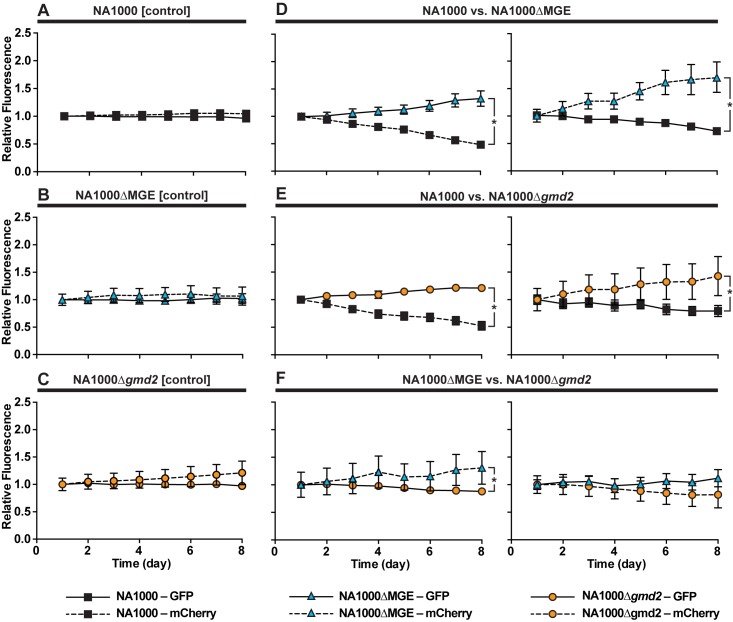
EPS production may be disadvantageous in phage-free environments.Strains labeled with two different fluorophores (GFP, mCherry) were mixed and relative fluorescence measured over the course of 8 days. (A–C) In control experiments where strains of the same genetic background expressing different fluorescent proteins were mixed, no significant change in the ratio of GFP:mCherry fluorescence was detected. Conversely, when strains of different genotypes were mixed, those producing more EPS appear to be at a competitive disadvantage (D) NA1000 and NA1000ΔMGE, (E) NA1000 and NA1000Δgmd2, or (F) NA1000ΔMGE and NA1000Δgmd2. The difference in fluorescence ratio between GFP and mCherry was assessed at the beginning (Day 1) and end (Day 8) of the experiment using an ANOVA with Bonferroni correction for multiple comparisons. Comparisons that resulted in significant differences are indicated with an asterisk (*) in the figure. (Day 1: ANOVA F(17, 558) = 0.0009178, P > 0.9999; Day 8: ANOVA F(17, 554) = 16.40, P < 0.0001, NA1000-GFP vs. NA1000-mCherry, t(554) = 1.051, p > 0.9999, NA1000ΔMGE-GFP vs. NA1000ΔMGE-mCherry t(554) = 0.5479, p > 0.9999, or NA1000Δgmd2-GFP vs. NA1000Δgmd2-mCherry t(554) = 2.479, p = 0.1213, NA1000-mCherry vs. NA1000ΔMGE-GFP t(554) = 8.892, p = < 0.0001, NA1000-GFP vs. NA1000ΔMGE-mCherry t(554) = 10.11, p = < 0.0001, NA1000-mCherry vs. NA1000Δgmd2-GFP t(554) = 5.038, p = < 0.0001, NA1000-GFP vs. NA1000Δgmd2-mCherry t(554) = 4.655, p = < 0.0001, NA1000ΔMGE-mCherry vs. NA1000Δgmd2-GFP t(554) = 3.099, p = < 0.0184, NA1000ΔMGE-GFP vs. NA1000Δgmd2-mCherry t(554) = 2.201, p = 0.2532).